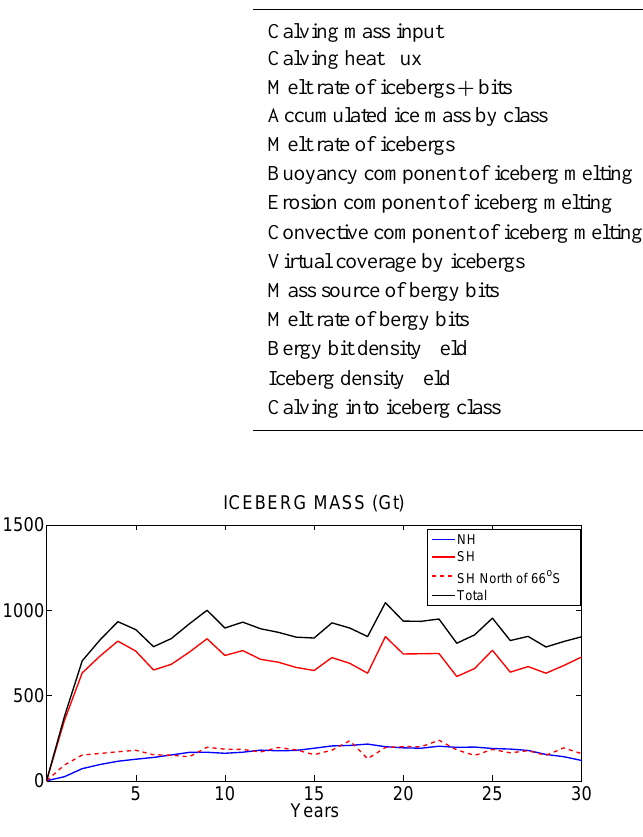
Figure 1. Time series of total iceberg mass (1Gt = 10 9 tonne = 10 12 kg); southern hemispheric and northern hemispheric iceberg mass is indicated by the red and blue lines, respectively. Southern hemispheric iceberg mass north of 66 ◦ S (dashed red line) is shown for comparison with observations of Tournadre et al.